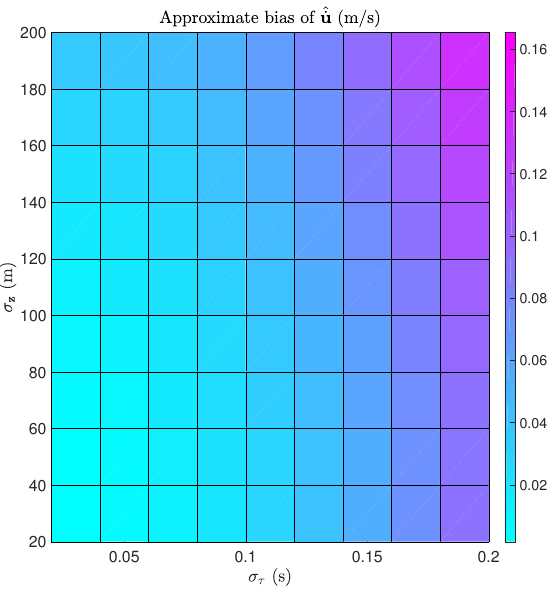
Figure 6. Surface plot of norm of the approximate bias of ˆ˙ u